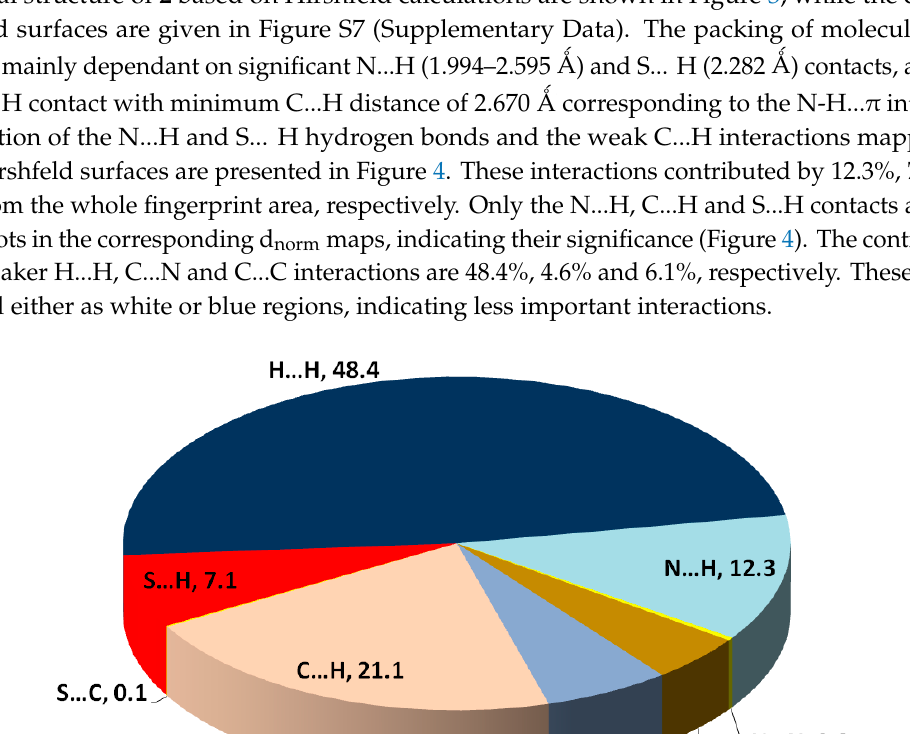
Figure 2. Intermolecular contacts ( A ) and packing ( B ) of molecular units in 2 . For clarity, the N-H... π interactions are labelled in magenta dotted lines.